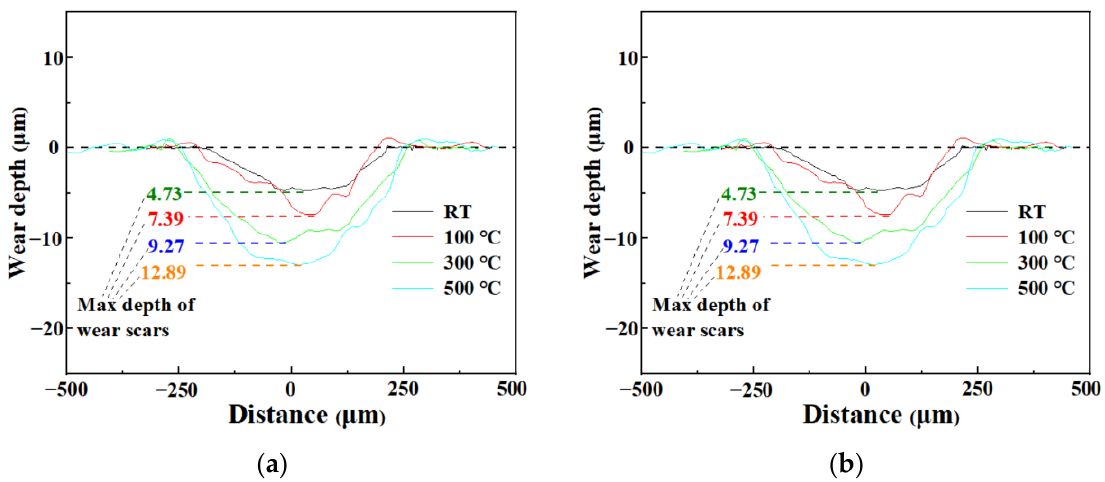
Figure 7. Wear scar profiles of Cr/W-DLC/DLC multilayer films under ( a ) no-sand condition and ( b ) sand condition at various